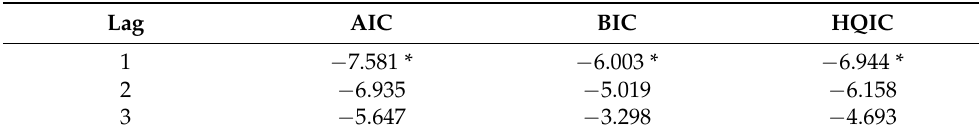
Table 5. Test results of optimal lag order selection.